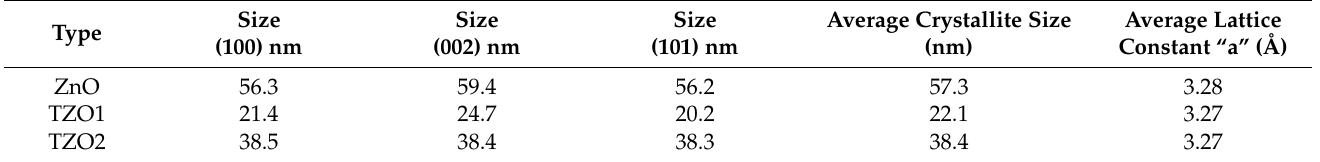
Table 1. Crystallite size calculated from XRD analysis. Adapted from Ref.